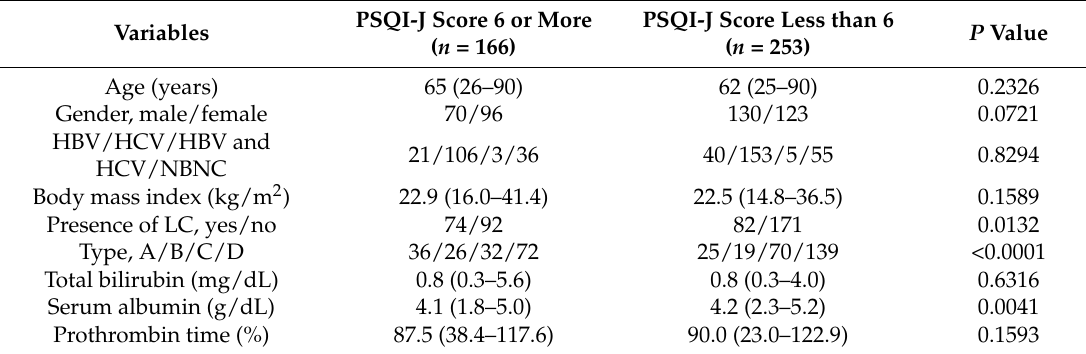
Table 3. Univariate analyses of factors linked to PSQI-J score 6 or